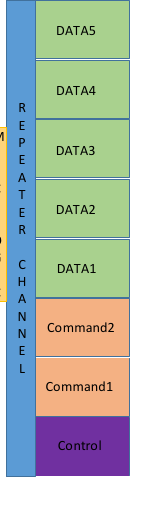
Figure 1. Reference HIP Floorplan